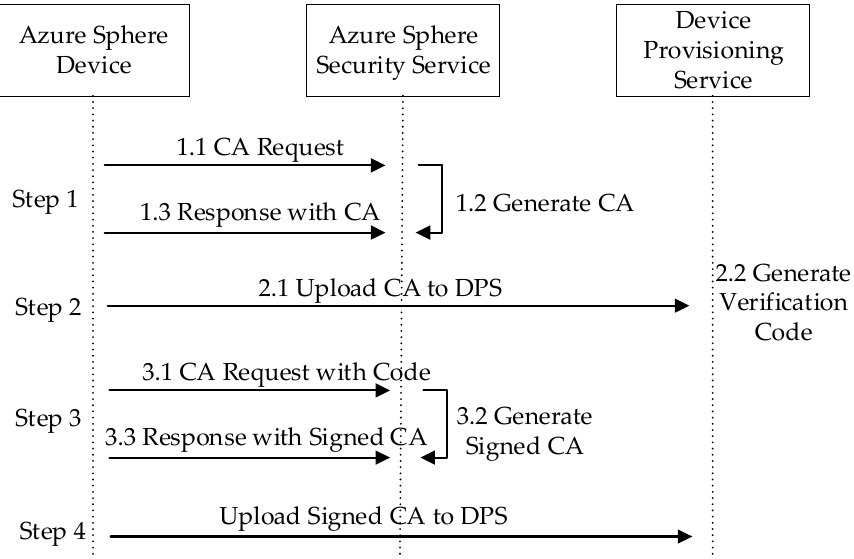
Figure 2. Azure Sphere device provision with Security Service and Device Provisioning Service.